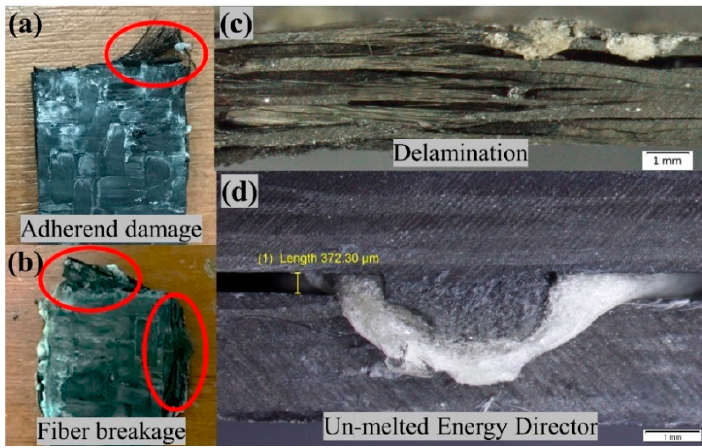
Figure 8. Initial welding trials ( a , b ) over-bonded when welded at higher pressure of 5-bar ( c ) delamination observed when welded at higher amplitude of 100% ( d ) un-bonded joints when welded at a lower pressure of 2-bar.